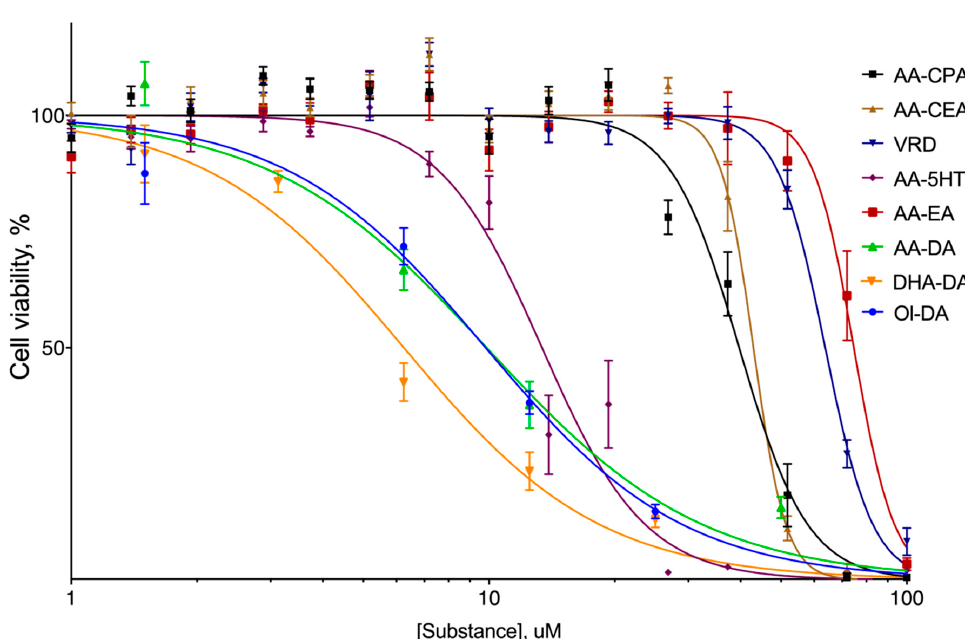
Figure 2. The cytotoxicity of the synthesized fatty acid esters and ethers for the undifferentiated PC12 cell line, 24 h incubation time, MTT assay. n = 5 experiments, M. ± S.E. AA-CPA, N-arachidonoyl cyclopropyamine, AA-CEA, N-arachi-